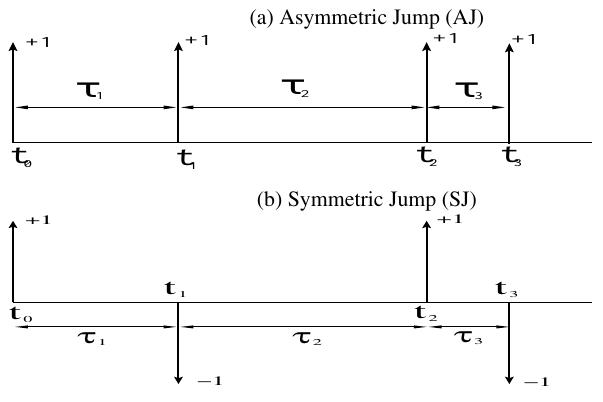
Fig. 6. Diffusion scaling H vs. complexity index µ for SJ and AJ walking rules: AJ (continuous line), SJ (dotted-dashed